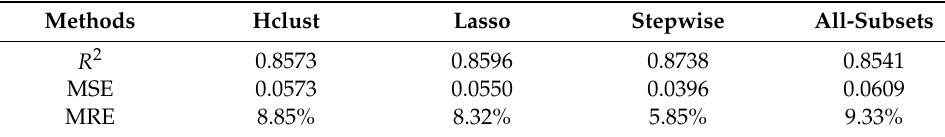
Figure 7a–c are histograms of 𝑅 (cid:2870) , MSE, and MRE on the training set, respectively. It can be seen from Figure 7 and Table 8 that in the training set, the largest 𝑅 (cid:2870) of the four methods is the stepwise regression SVR model, and the second is the Lasso SVR model. The corresponding 𝑅 (cid:2870) is 0.8738 and 0.8596, respectively. The minimum MSE is the SVR